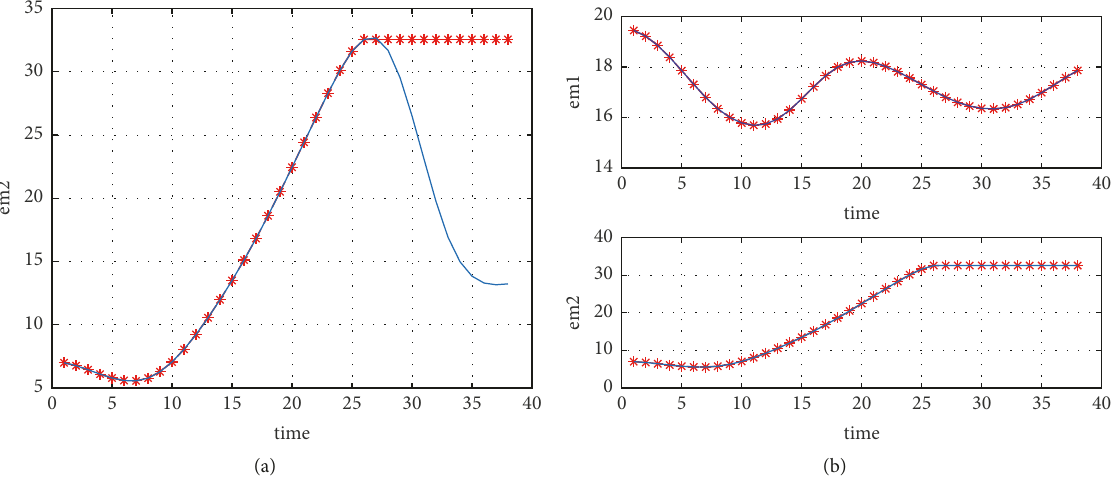
Figure 6: Step fault in IEMG signal. (a) Healthy and faulty IEMG signal. (b) Real and estimated faulty